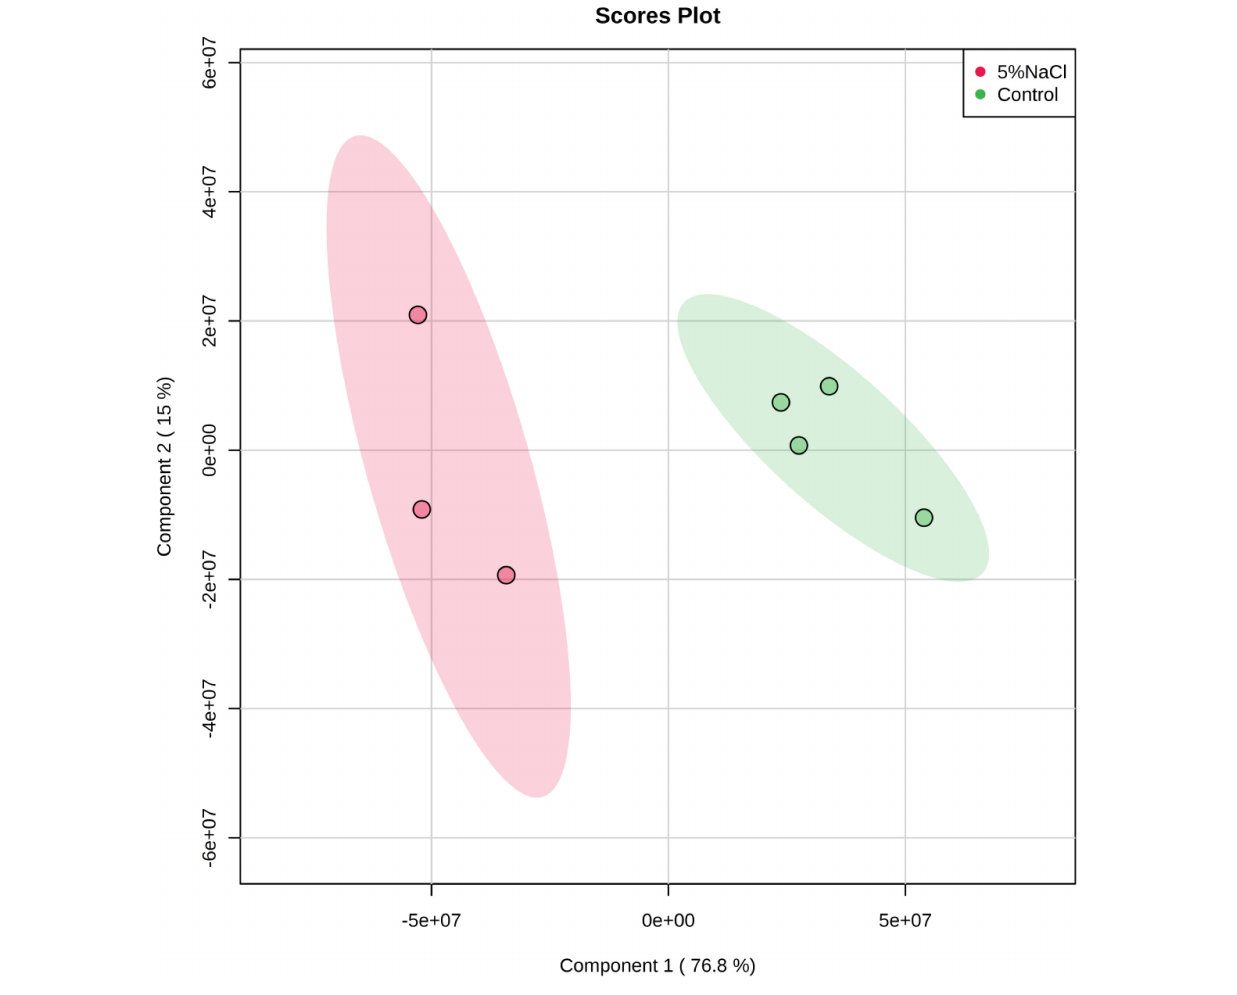
FIGURE 6 | Partial least Square-discriminant analysis (PLS-DA) scores (component 1 versus component 2) plotted from S. aureus metabolomic data. The S. aureus cells were incubated in a defined minimal medium (control, n = 4) or with the presence of additional NaCl (5% NaCl, n = 3) before extraction of metabolites and analysis by